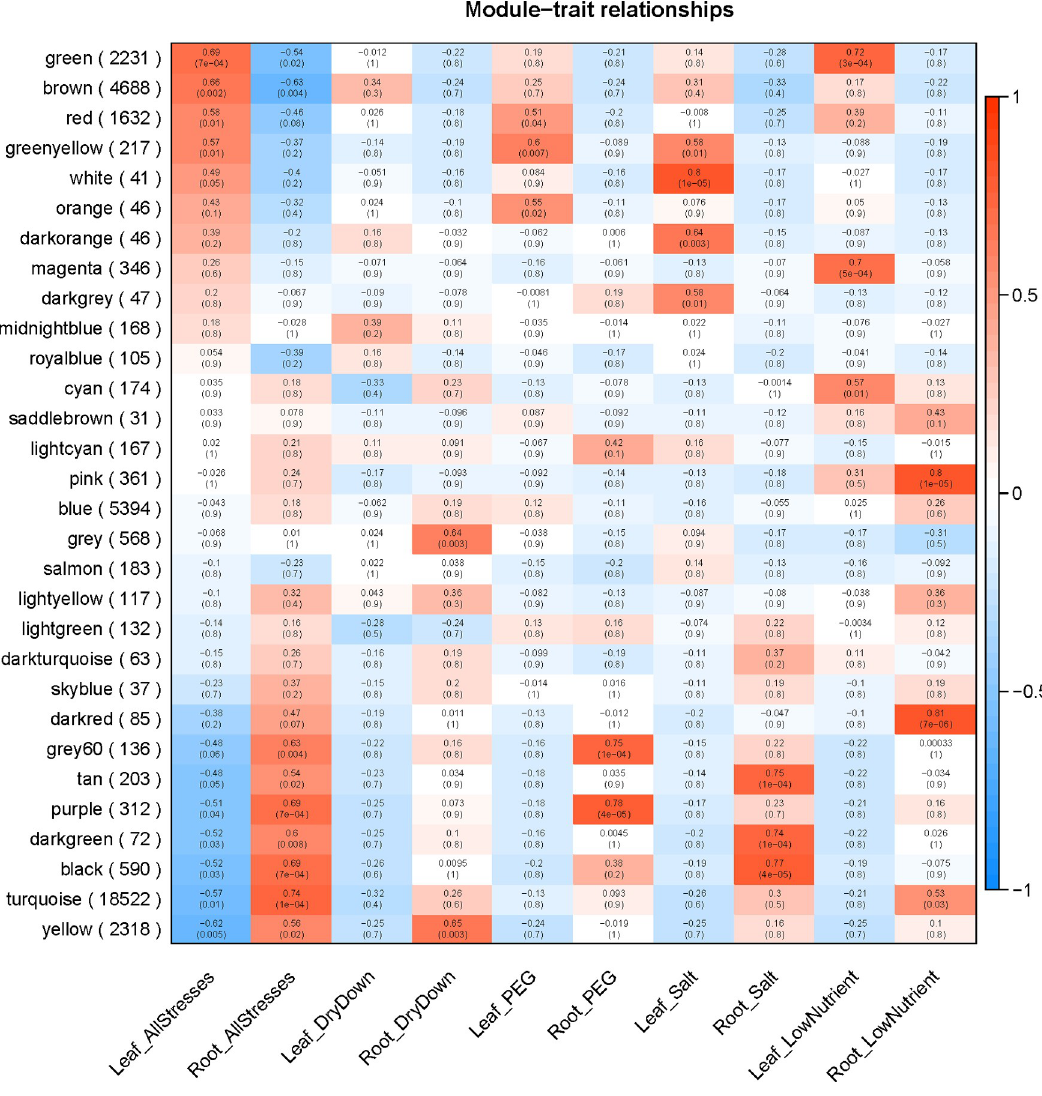
Fig 4. Visual depiction of correlations between gene co-expression modules and tissue/treatment. Correlation values (upper text) and P -values (lower, parenthetical text) are presented in each cell. Color is determined by the sign and magnitude of the correlation. Positive correlations (red) indicate genes within a module are upregulated within a stress/tissue combination while negative correlations (blue) indicate that genes within the module are downregulated.